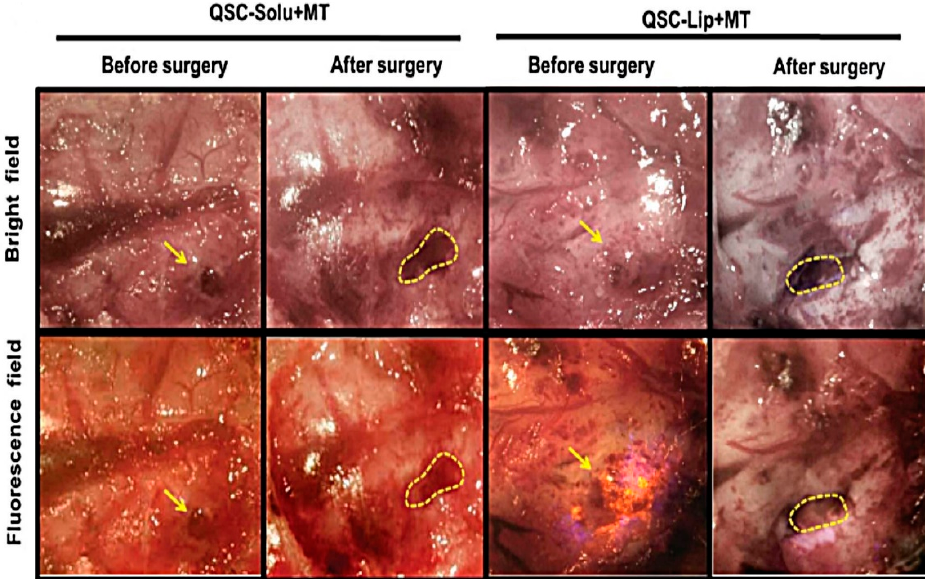
Figure 3. Surgical resection led by bright light and fluorescence of both; glioma in the quantum-dot–cilengitide under magnetic targeting and glioma in the quantum-dot–cilengitide–liposomal system under magnetic targeting groups, where the yellow arrow represents the glioma and the dotted lines represent the cavity after the tumor resection. This image was reproduced with permission from [70]. Copyright ©, 2018, John Wiley and Sons Ltd.